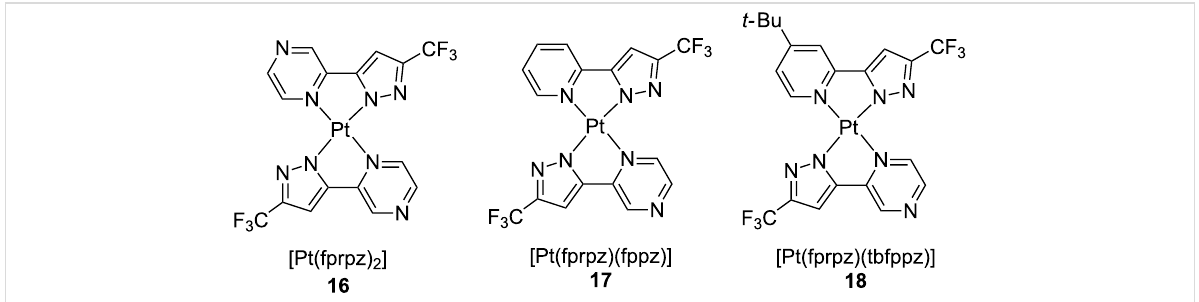
Figure 8: Chemical structure of neutral platinum(II) complexes 16 – 18 bearing azine-pyrazolato bidentate ligands [14].